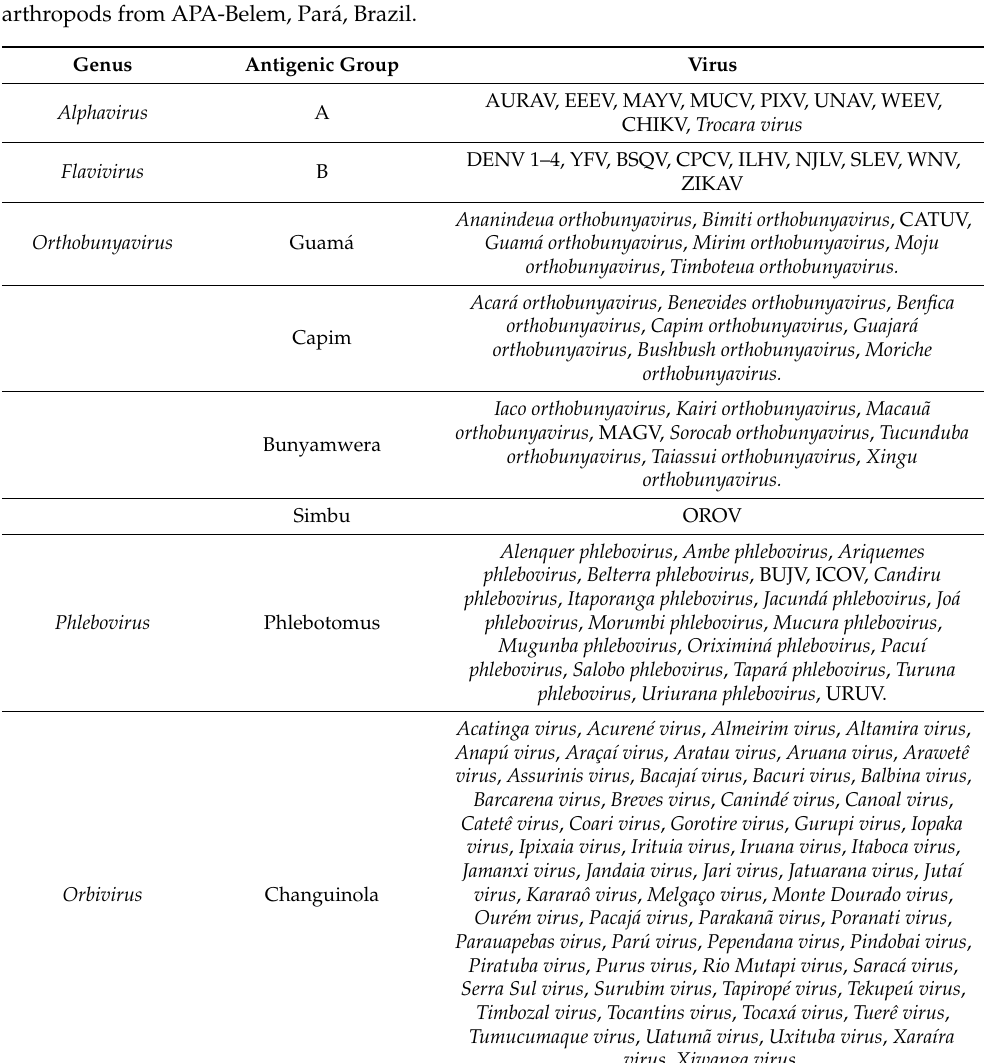
Table 2. Polyclonal antibodies for antigenic groups of arboviruses used in the IFF test to detect viral presence in C6/36 and VERO cell cultures inoculated with supernatant of macerated hematophagous arthropods from APA-Belem, Par á ,